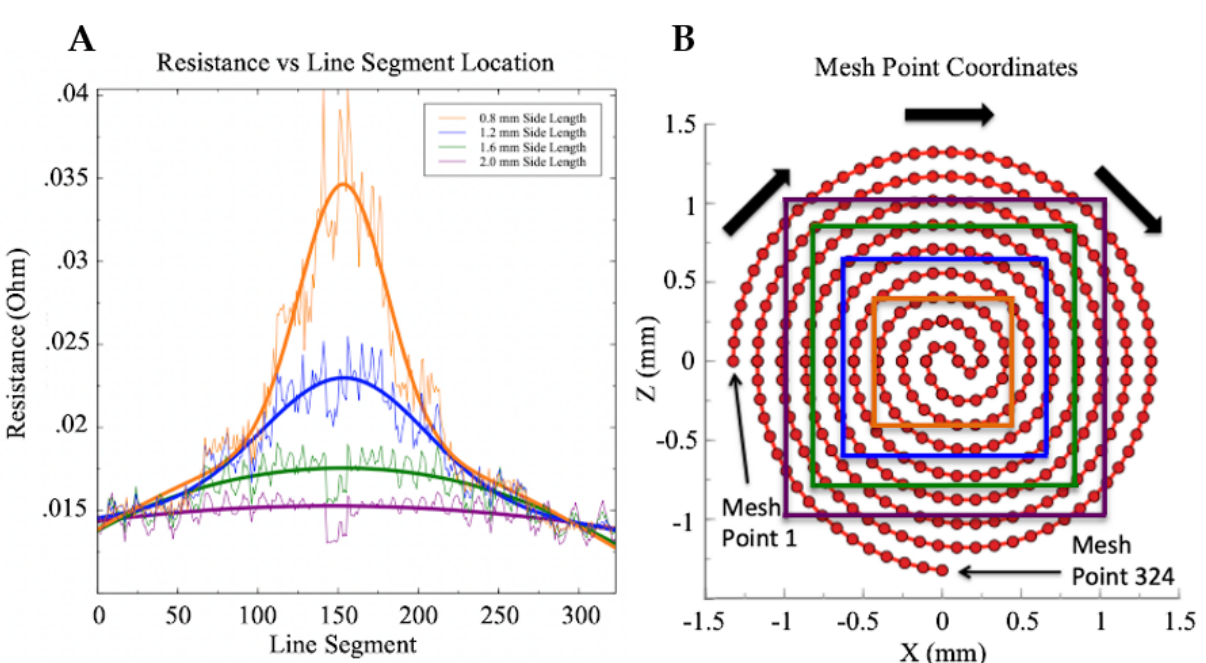
Figure 8. ( A ) Small central compressions displayed an exponential increase in resistance of central line segments. As in Figure 3B, the sensor channel is made up of 324 line segments, with the center being composed of segments 150–170. The figure above displays the resistance generated per segment. As expected, the resistance per segment drastically increased in the center of the sensor when a concentrated pressure was applied. As the central compression area increased, the resistance per segment decreased towards the center of the sensor decreased. ( B ) The above figure represents Figure 3B overlaid with the compression area used in each simulation trial. Each color of the square contacts corresponds to the curves plotted in ( A ).